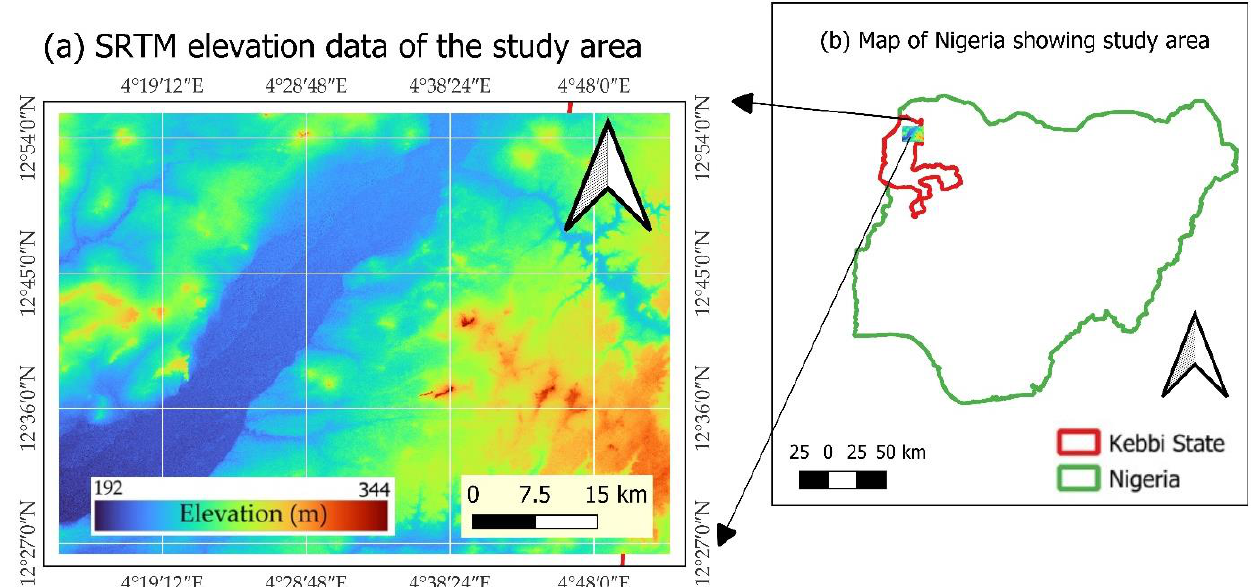
Figure 1. Study area ( a ) study area showing the elevation data based on SRTM data, ( b ) Map of Nigeria showing Kebbi State and the location of the study area.